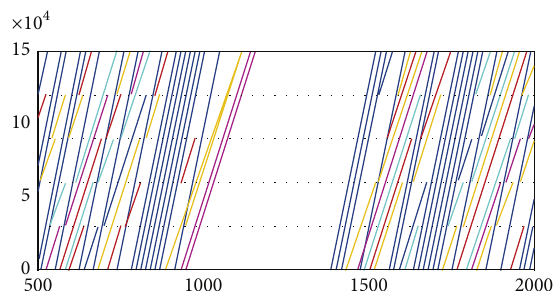
Figure 5: Train operation diagram considering maintenance win-